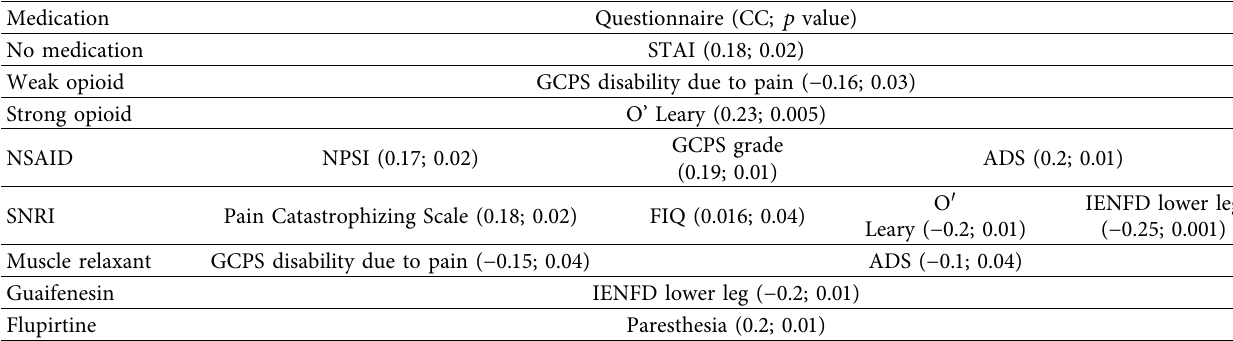
Table 6: Correlations between the use of certain classes of medication and clinical symptoms and the IENFD in the lower leg.